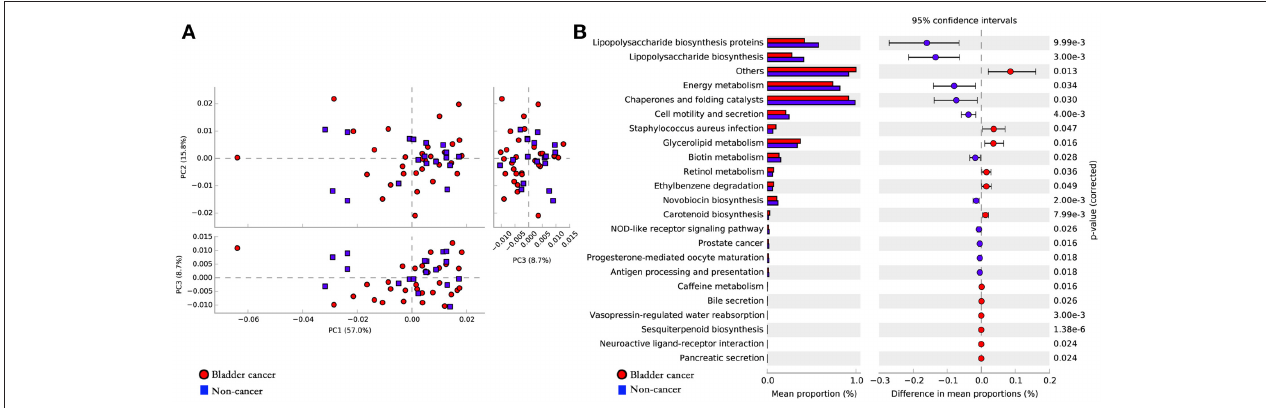
FIGURE 5 | Potential functional pathways associated with bladder cancer. (A) Principal component analysis (PCA) plot comparing the metagenome predictions (for KEGG orthology using PICRUSt) of the microbiota of patients with bladder cancer and non-cancer. (B) Microbial pathways that were significantly differentially enriched between the cases and controls. Red indicates taxa enriched in cancer group and blue indicates taxa enriched in non-cancer